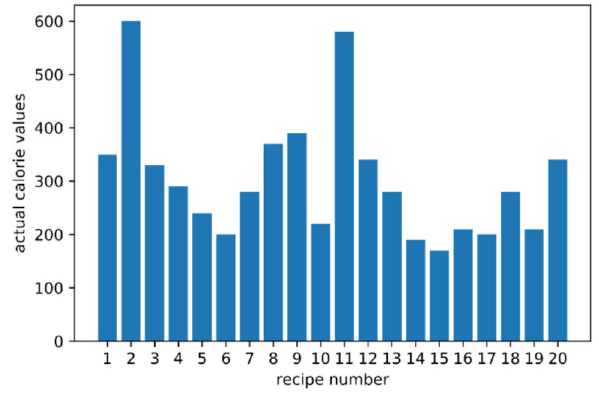
Fig. 9 Ingredients of existing recipes